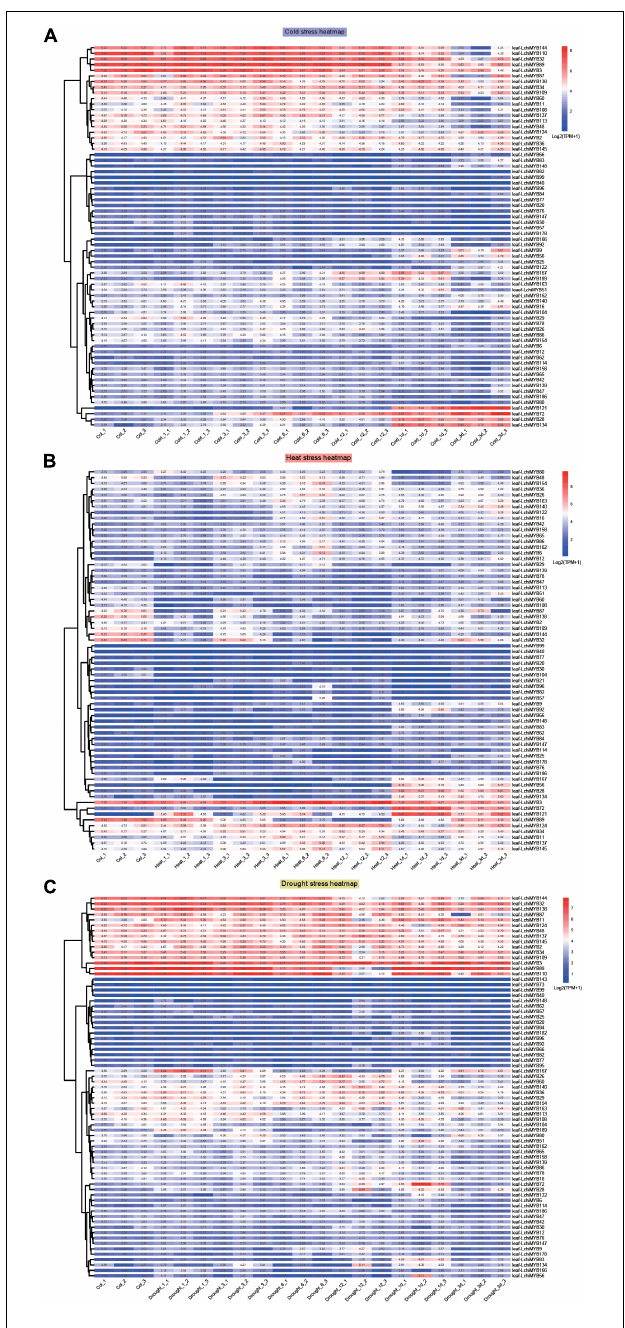
FIGURE 9 | Expression patterns of LchiMYBs under cold (A) , heat (B) , and drought (C) stress at six successive time intervals. Ctrl_1, Ctrl_2, and Ctrl_3 represent three biological replicates of the control group; Cold_1, Cold_3, Cold_6, Cold_12, Cold_1d, Cold_3d, Heat_1, Heat_3, Heat_6, Heat_12, Heat_1d, Heat_3d, Drought_1, Drought_3, Drought_6, Drought_12, Drought_1d, and Drought_3d represent three repetitions of each time point (1 h, 3 h, 6 h, 12 h, 1 day, and 3 days); leaf-LchiMYBs represent the leaf tissues used for RNA-seq analysis. The standardization and hierarchical clustering of the transcriptional expression level were calculated by log 2 (TPM + 1) values. Colored blocks show decreased (blue) or increased (red) transcriptional expression among the different time points. The heatmap was generated by the R package “pheatmap” (v 1.0.12).